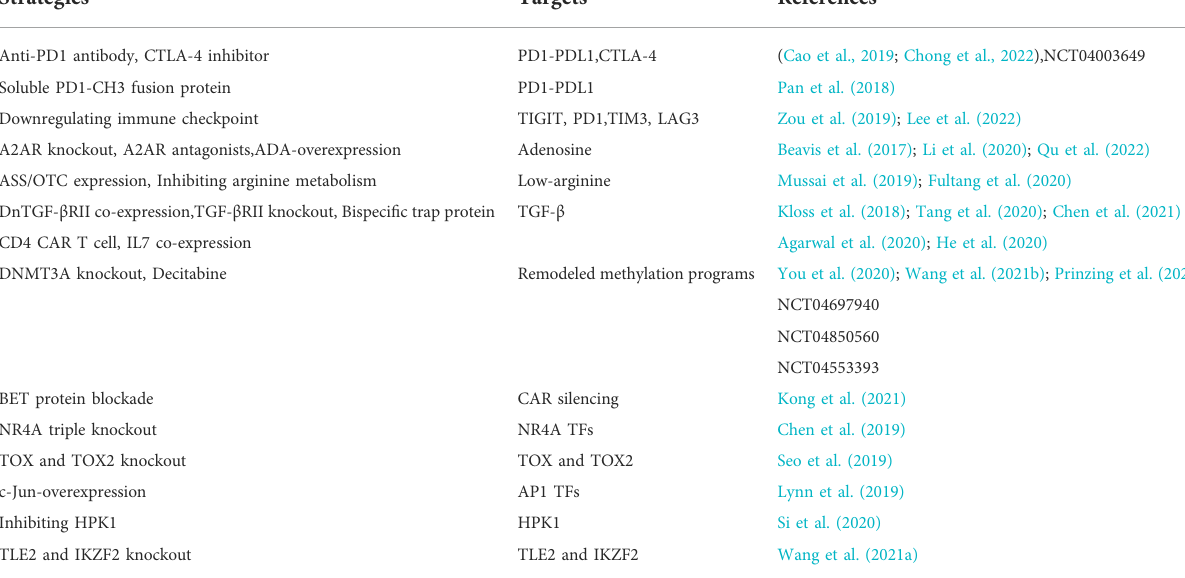
TABLE 1 Strategies for combating CAR T cell